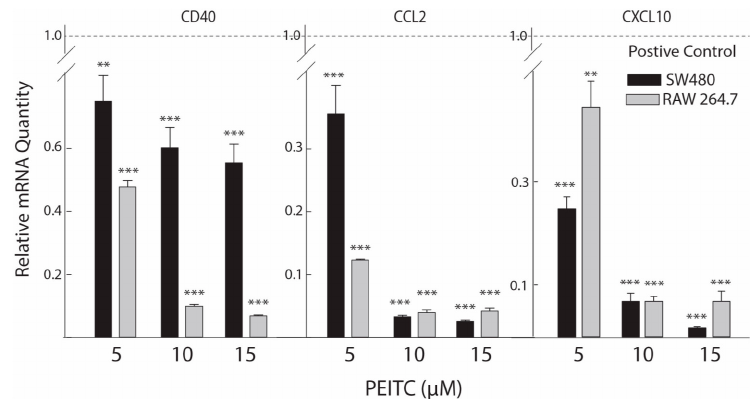
Figure 2. PEITC concentration-dependent mRNA expression of chemokines/cytokines. The effects of PEITC treatments were measured by the relative mRNA quantity expressed by chemokine/cytokine genes in the treated cells. Lower values represent greater inhibitory effects. Values are mean ± S.E. ( n = 3). ** p < 0.01, *** p < 0.001 compared with positive-control cells (LPS activation normalized to a value of 1.00). LPS, lipopolysaccharide.